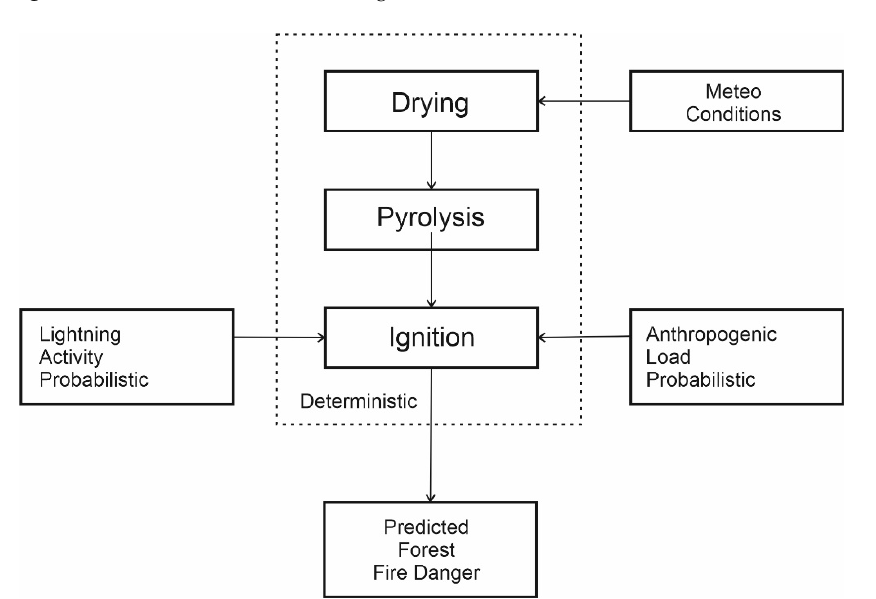
Figure 3. Deterministic–probabilistic prediction of forest fire danger.